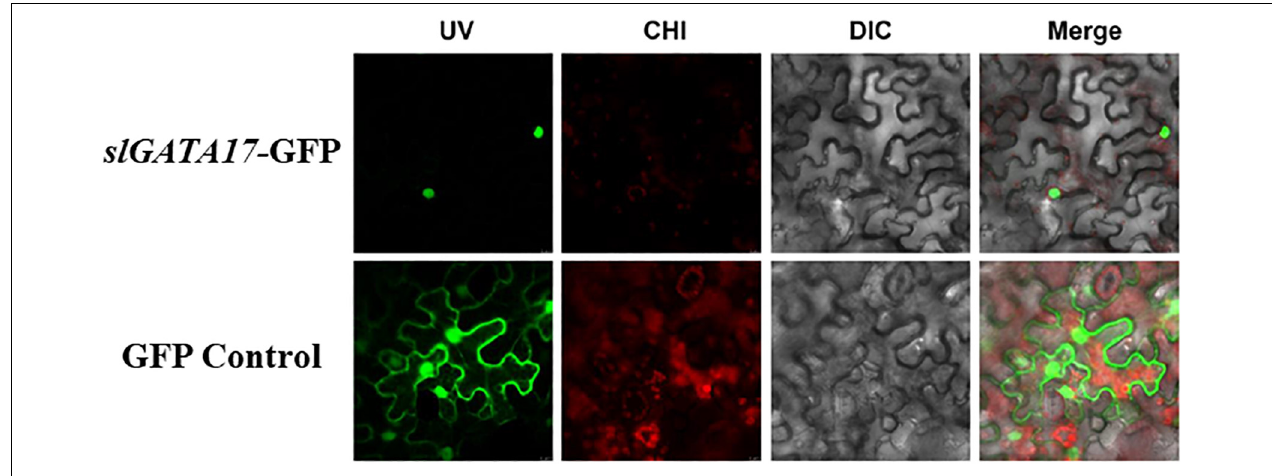
FIGURE 2 | Subcellular localization of SlGATA17 in tobacco leaf epidermal cells. The four images in each row from left to right are the green fluorescence signal, red fluorescence signal, light-field images, and merged images of the first